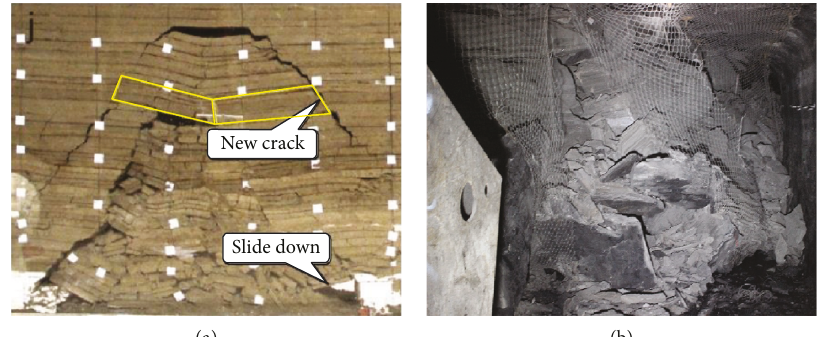
Figure 13: (a) Regular shape of caved fragments in a physical model of longwall mining [156]. (b) Field observations of the caved zone in a shallow buried coal seam with a thickness of 2.5